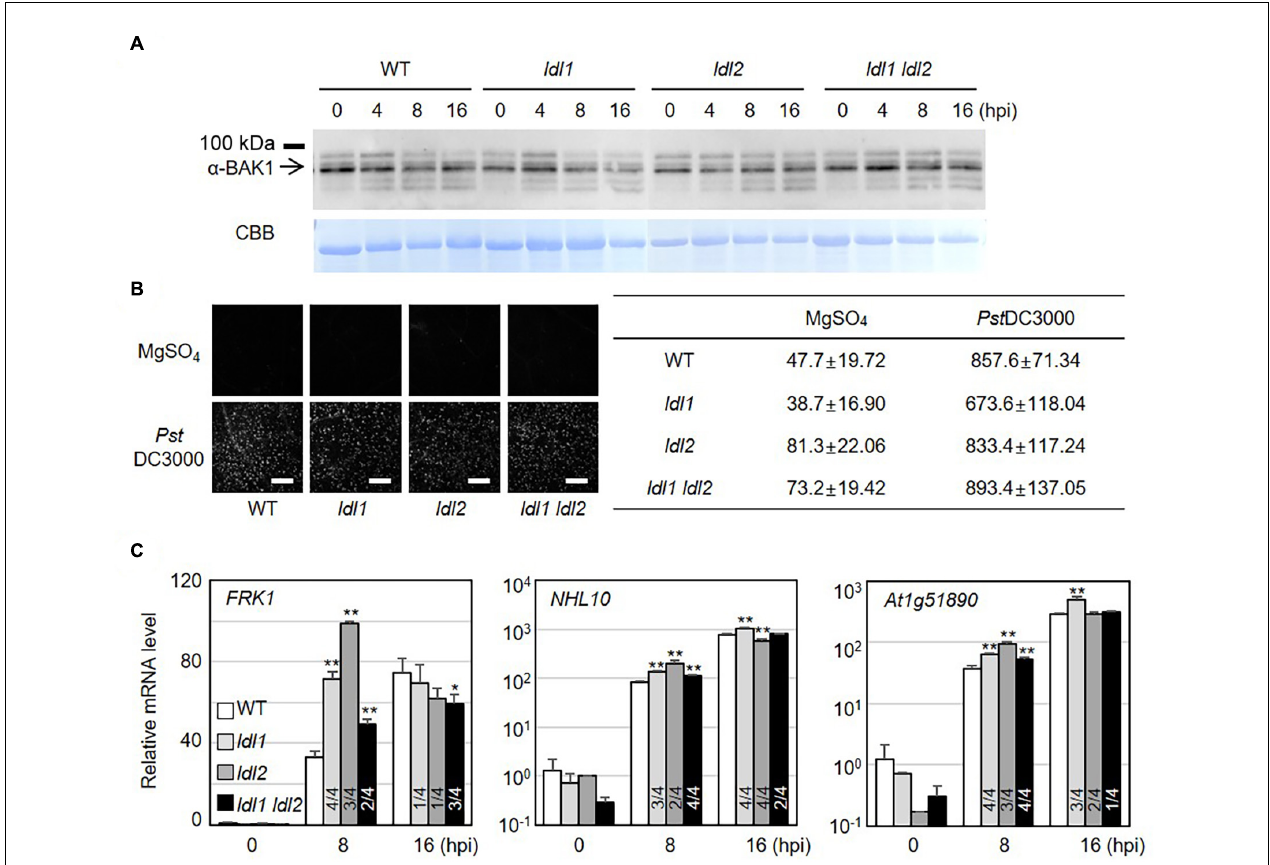
FIGURE 3 | Transcript levels of MAMP-responsive genes increase in ldl mutants after Pseudomonas infection. (A) BAK1 protein abundance in WT, ldl1 , ldl2 , and ldl1 ldl2 during Pst DC3000 infection (OD 600 = 0.01). (B) Callose deposition in Arabidopsis leaves infiltrated with Pst DC3000 at 24 h post-inoculation (hpi). Equivalent volumes of 10 m MgSO 4 were used for mock conditions. Left panel: representative portions of leaves from WT, ldl1 , ldl2 , and ldl1 ldl2 plants stained with aniline blue to visualize deposited callose. Right panel: average ± SD of the number of callose deposits per field ( n = 10) (Scale bars are 300 µ m). No significant differences from WT plants were observed when analyzed with a one-way ANOVA-Tukey test ( p < 0.05). (C) Transcript levels of FRK1 , NHL10 , and At1g51890 in local leaves of WT, ldl1 , ldl2 , and ldl1 ldl2 plants at 0, 8, and 16 hpi with Pst DC3000 (OD 600 = 0.01). Bar indicates the SD (* p < 0.05, ** p < 0.01, two-tailed Student’s t -test, n = 3). The experiments were repeated 4 times; the numerators of the fractions below each plot indicate the number of trials showing differences from WT